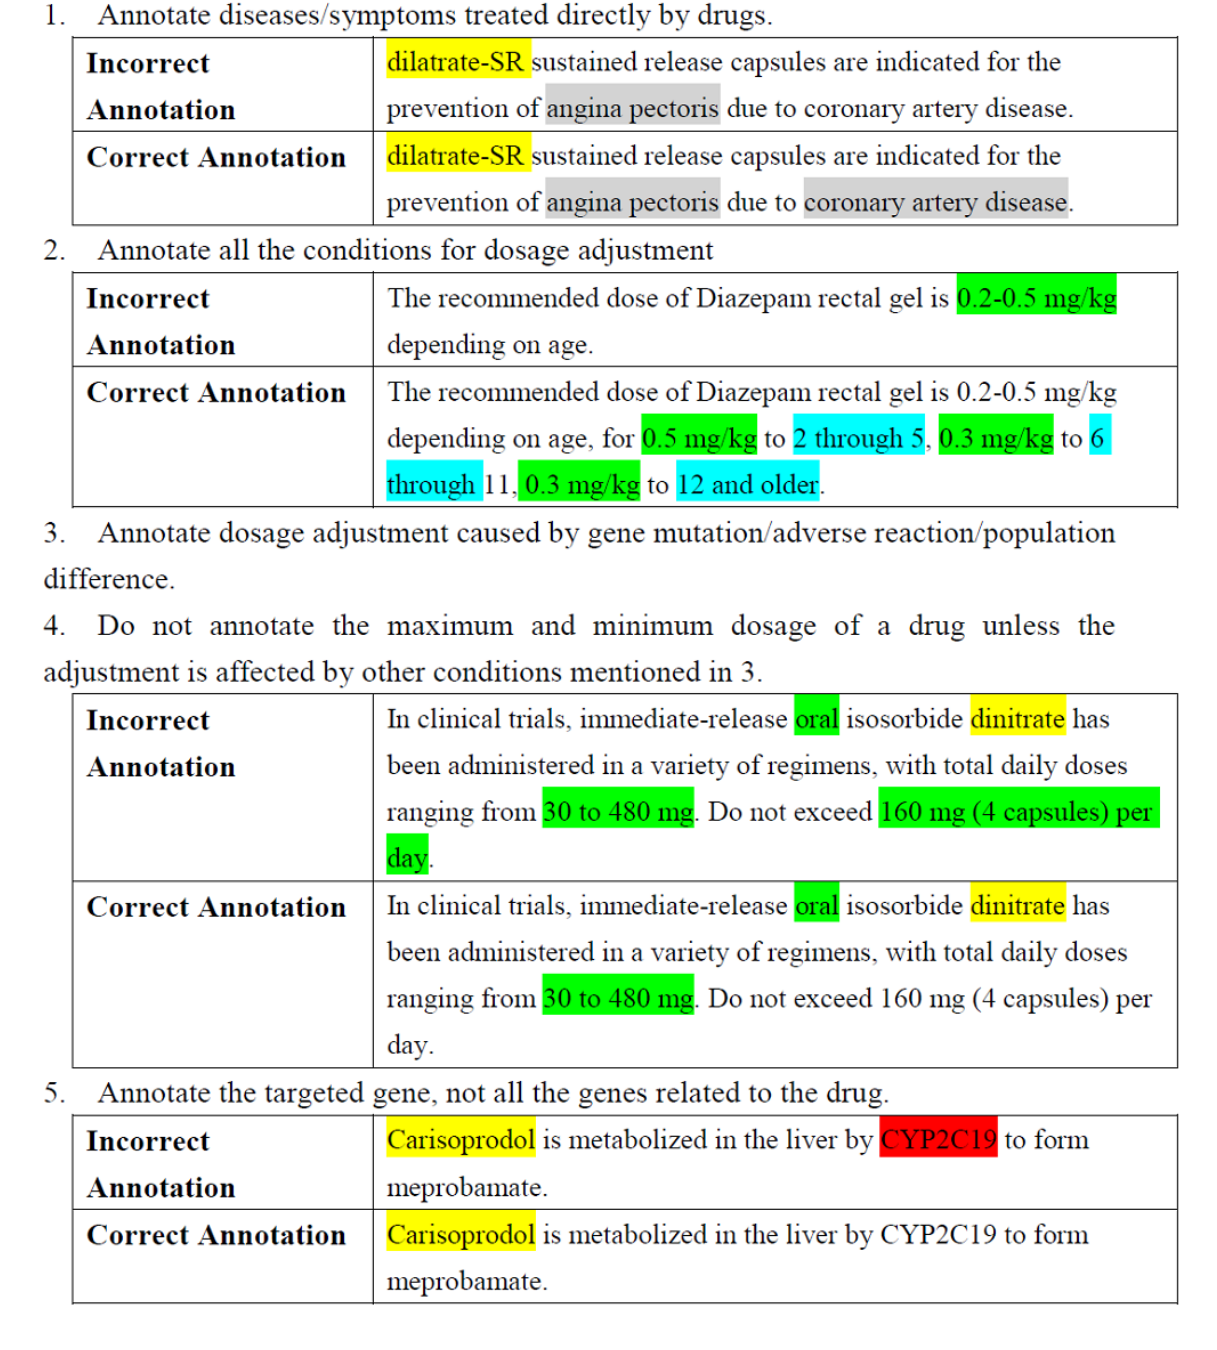
Figure 2. Annotation